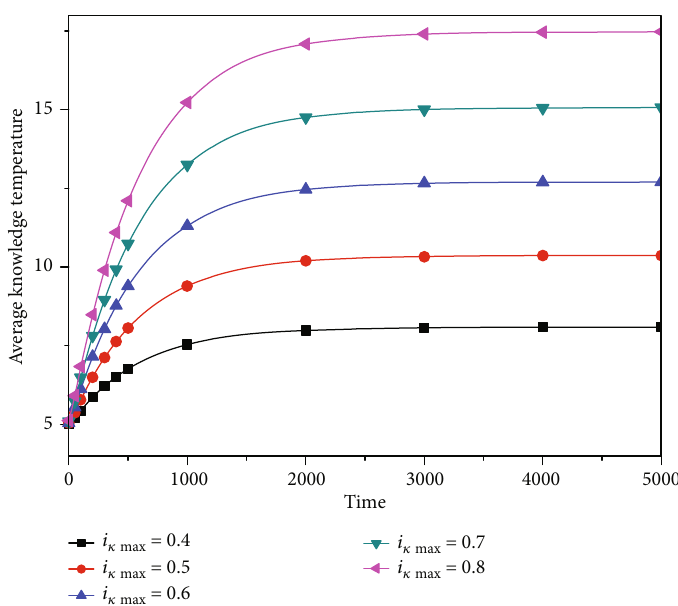
Figure 2: Average knowledge temperature on di ff erent knowledge innovation coe ffi cients.